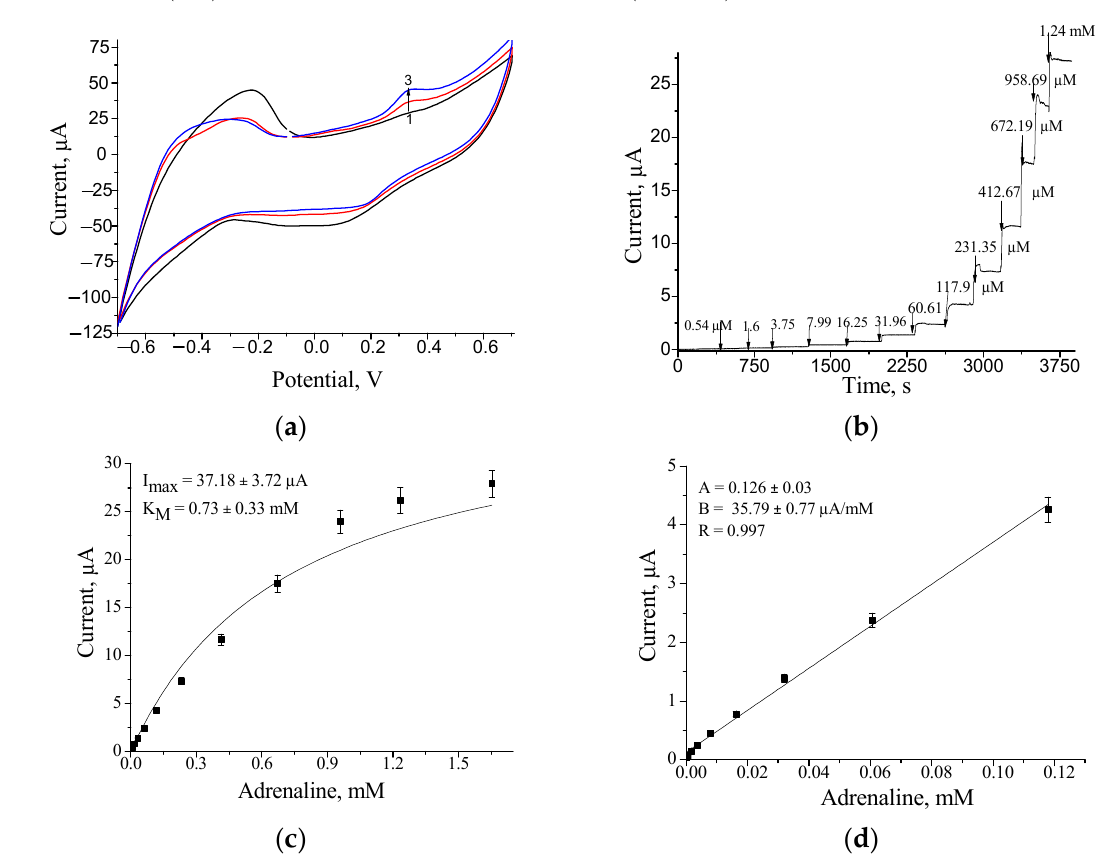
Figure 4. Characteristics of nPtFe/GE: CV as current responses upon AD addition up to 0 mM (1, black line), 4 µ M (2, red line) and 8 µ M (3, blue line), concentrations ( a ); chronamperometric response ( b ), dependence of amperometric signal on concentration of AD ( c ) and calibration graph ( d ) under working potential +250